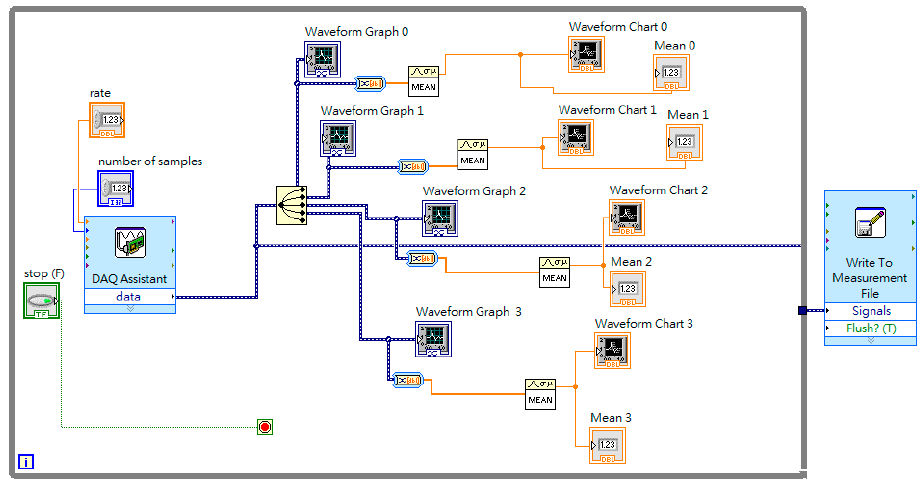
Figure 9. Block diagram of strains measured from the composite plate.